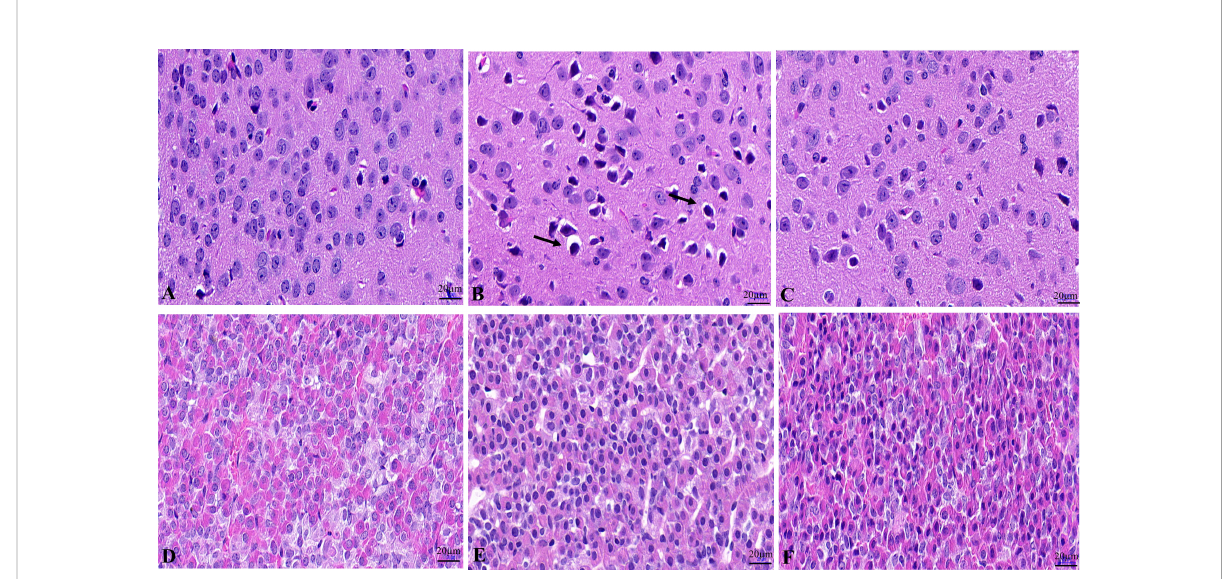
FIGURE 1 Histopathological changes of the hypothalamus and pituitary in male mice. Histopathological changes of hypothalamus in NC group (A) , WD group (B) and DMSA group (C) . Histopathological changes of pituitary in NC group (D) , WD group (E) and DMSA group (F)